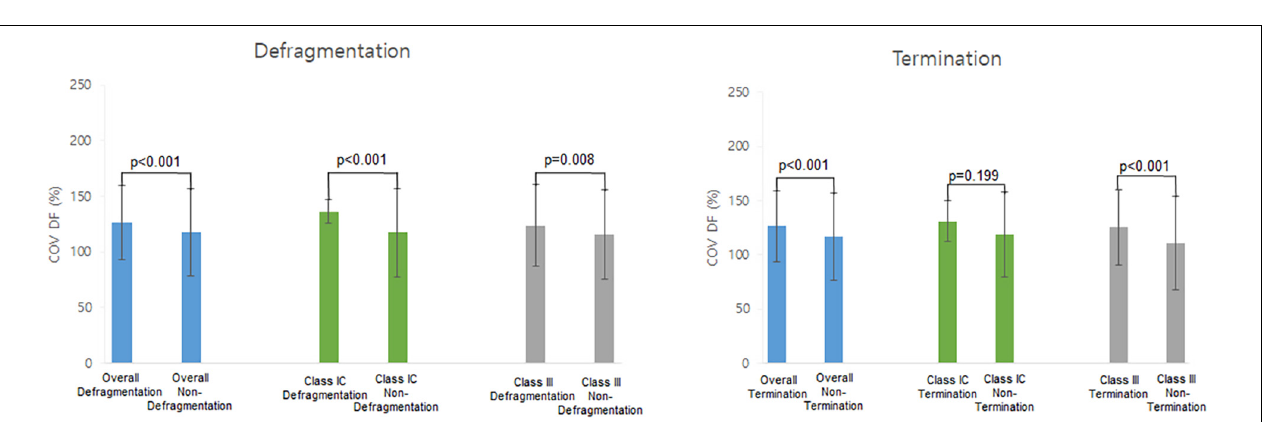
FIGURE 4 | Changes in the dominant frequency (DF) during Termination and Atrial Tachycardia. The 3D DF map indicated that the mean DF was lower during AT episodes, and AF termination episodes. Electrograms demonstrated AT and AF termination episodes.